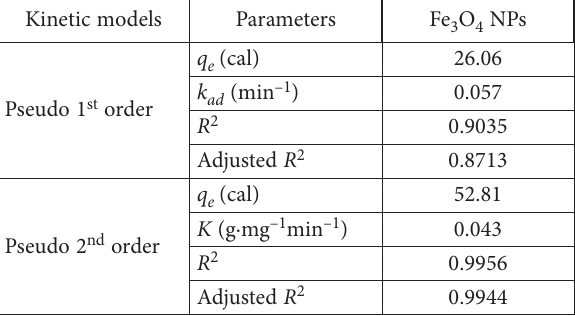
Figure 10. Plot showing (a) Langmuir and (b) Freundlich isotherm values for lead Table 2. Kinetic model and parameter values for the lead (II) adsorption on the magnetic NPs